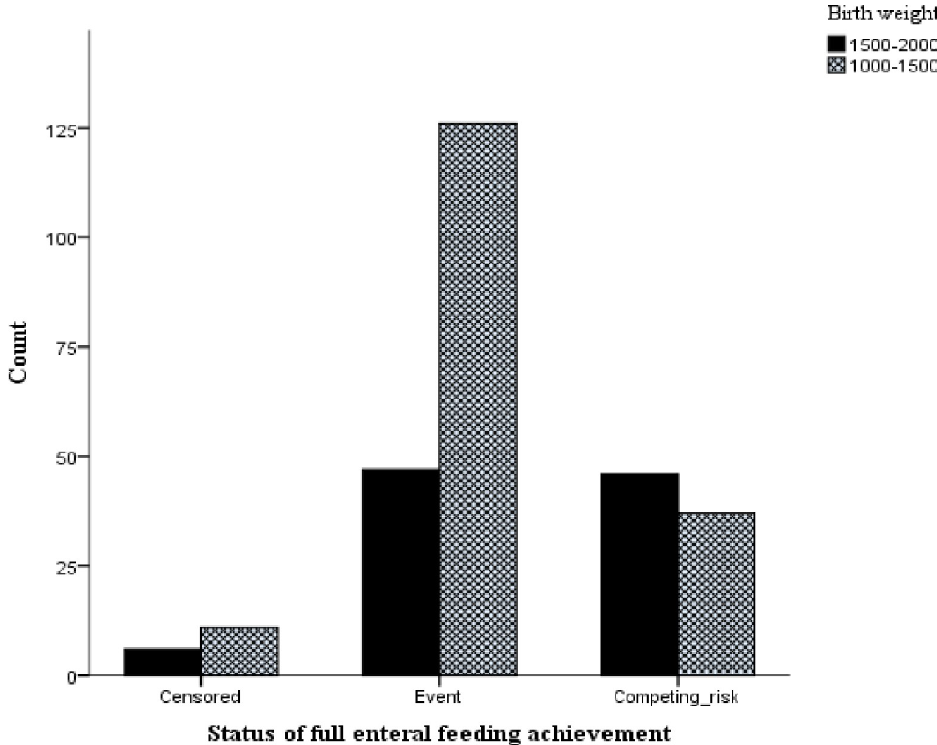
Fig 2. Status of full enteral feeding achievement with respect to the birth weight of neonates admitted to the neonatal ICU.